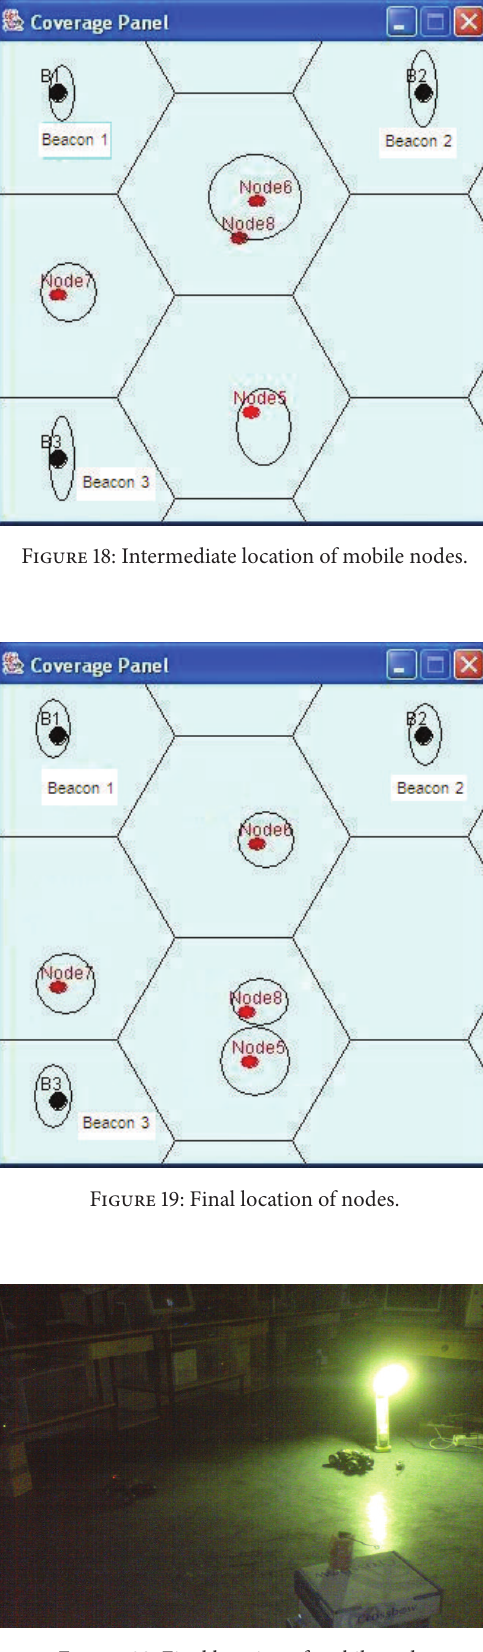
Figure 20: Final location of mobile node.